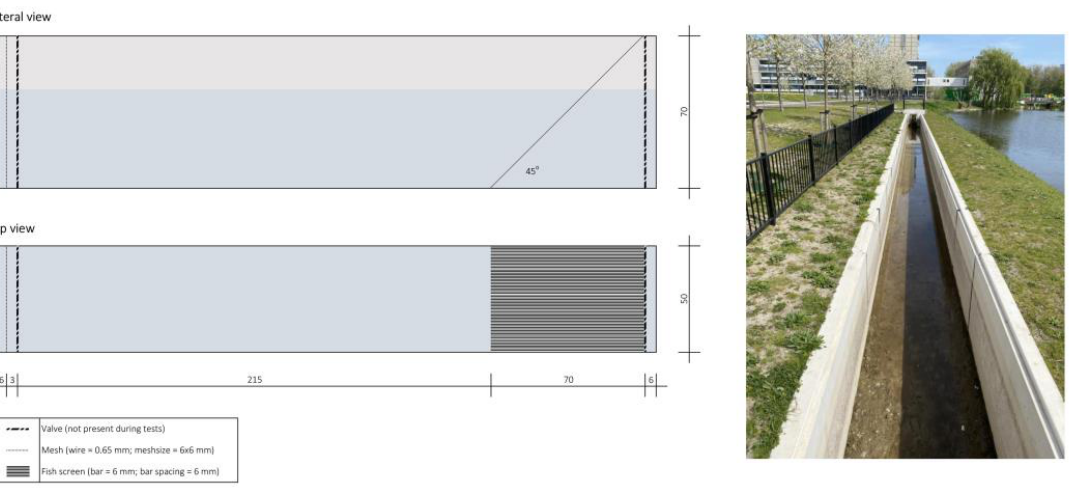
Figure 1. Diagram of an experimental chamber ( left ) and view of the TU Delft flume, where experiments took place ( right ). Dimensions of the chamber, unless otherwise stated, are expressed in cm.